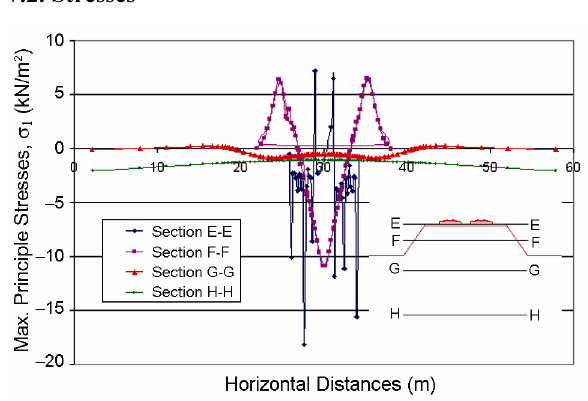
Fig. 7. Distribution of maximum principal stresses (σ 1 )